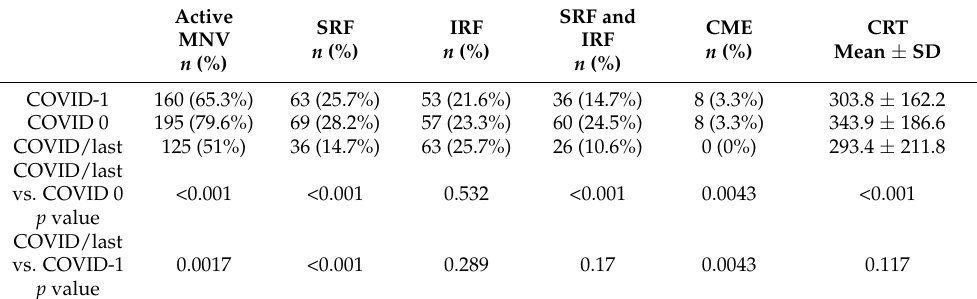
Table 3. Structural parameters assessed by OCT at different visits.